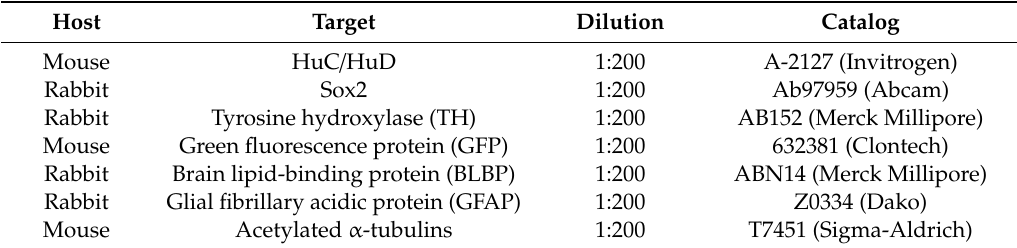
Table 1. Antibodies utilized for